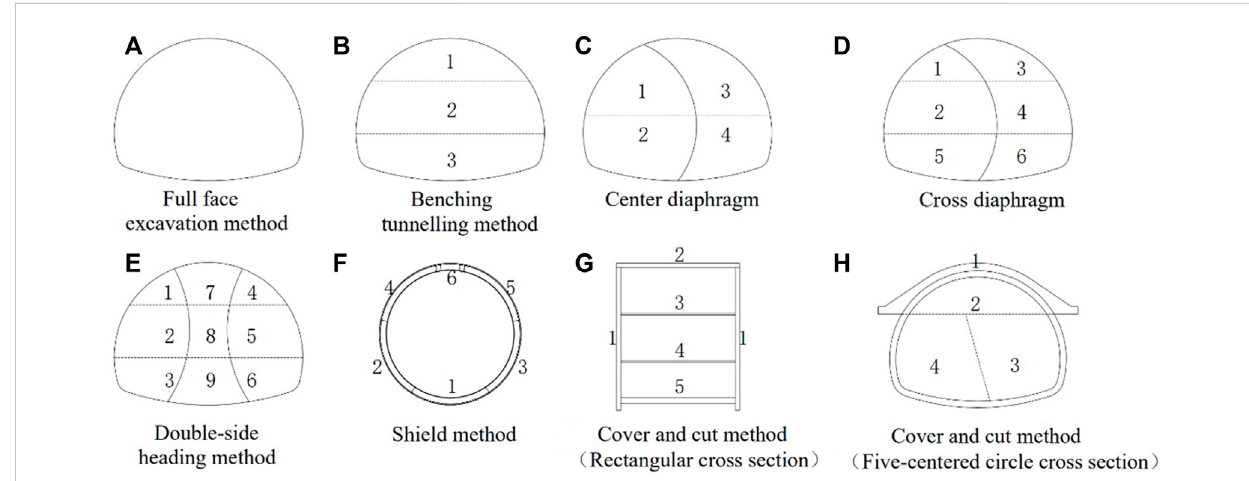
FIGURE 2 Cross-sectional models for different tunnel construction method: (A) Full face excavation method; (B) Benching tunnelling method; (C) Center diaphragm; (D) Cross diaphragm; (E) Double side heading method; (F) Shield method; (G) Cover and cut method (Rectangular cross section); (H) Cover and cut method (Five-centered circle cross section).